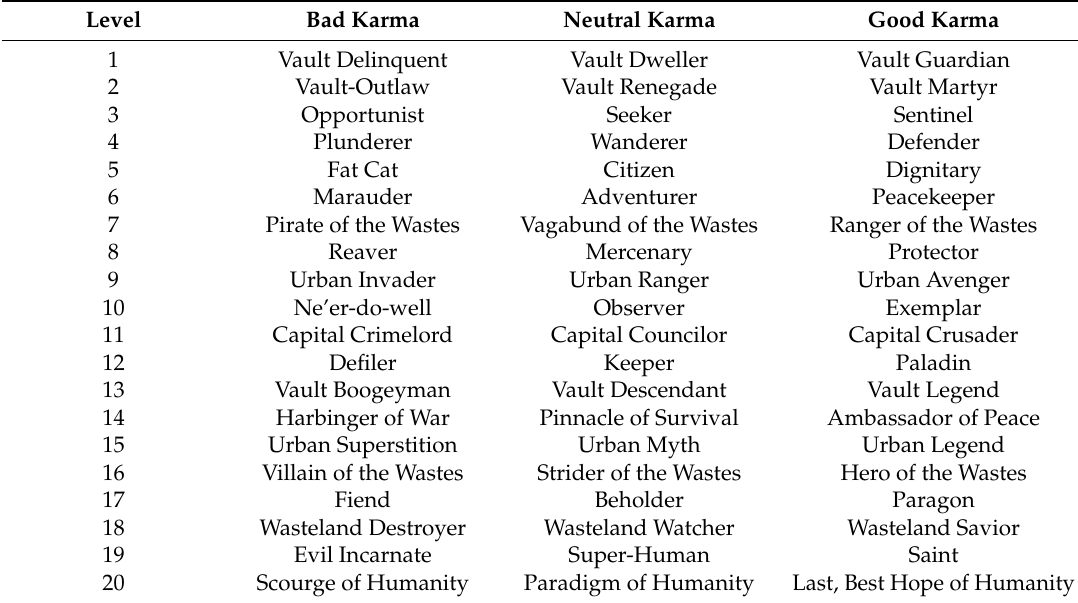
Table 1. Karma Titles in Fallout